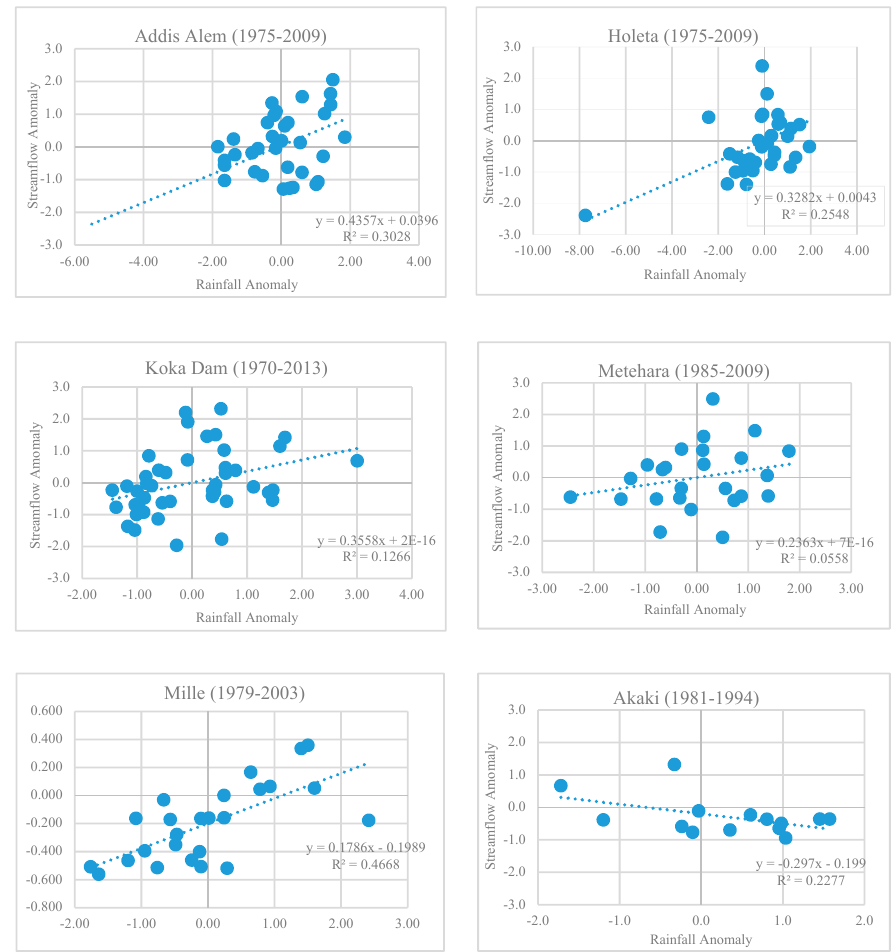
Figure 11. Relationship between rainfall and streamflow trend in the ARB .